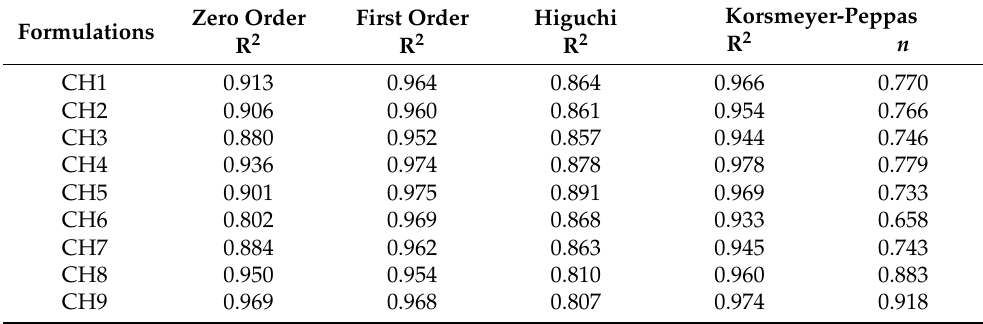
Table 2. Dissolution data modeling showing release kinetics of captopril from hydrogels.